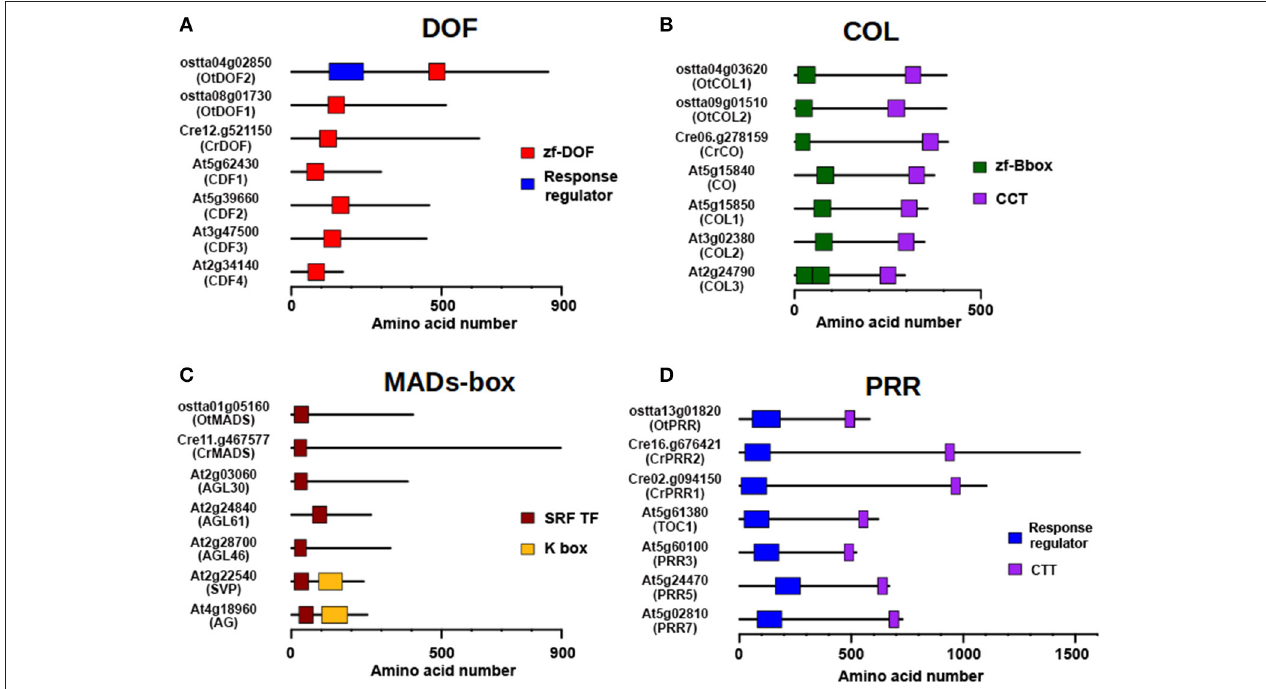
FIGURE 4 | Amplification of TF families through evolution. Arabidopsis TF families are respectively on average five and eight times larger than Chlamydomonas or Ostreococcus ones, indicating an evolutionary history with multiple gene duplication events. (A) Domain structure of DOF proteins. Ostreococcus has two members; one of them exhibiting a Response Regulator domain in the N-terminal (OtDOF2), while it is constituted by a single member in Chlamydomonas . Of the 47 members of the family in Arabidopsis , the closest homologs to algal DOFs are the CDFs, involved in photoperiodic flowering. (B) Domain structure of the COL TF family. It has two members in Ostreococcus , a single member in Chlamydomonas and 22 in Arabidopsis . Some variation in the number of B-boxes in the N-terminal domain is observed. CO and closest homologs are shown. (C) Domain structure of the MADS-box TF family. This family has gone through an intense process of amplification from the single copy gene present in Ostreococcus and Chlamydomonas to the multi-gene family, constituted by 146 members, in Arabidopsis . The acquisition of novel protein domains in Arabidopsis would have given rise to different subfamilies. (D) Domain structure of PRR protein family. Although relatively small in Arabidopsis , with around 10 members, it has also been submitted to a process of gene amplification starting from the single copy gene in Ostreococcus and two genes in Chlamydomonas . Color boxes represent domains identified in pfam database including their identification